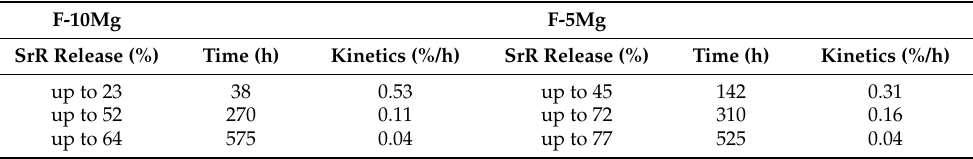
Table 2. Parameters describing the SrR liberation kinetics for F-5Mg and F-10Mg